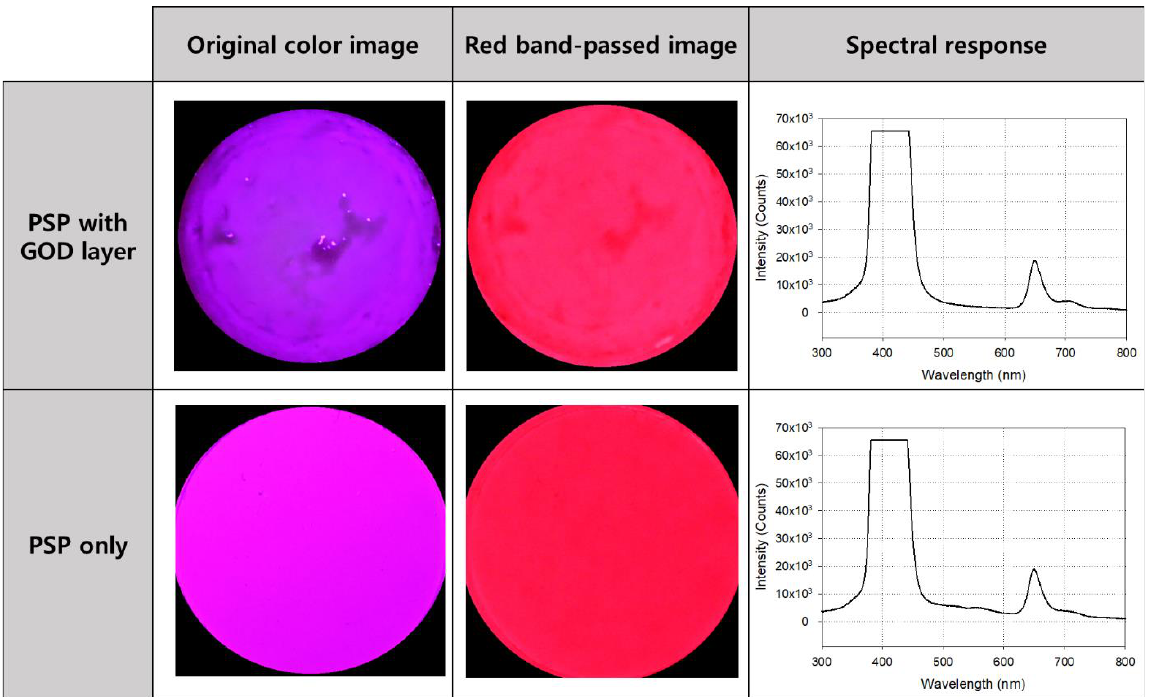
Figure 4. Photos and the excitation and emission spectrums of the sensor before (lower row) and after (upper row) the glucose oxidase (GOD) layer application. The spectral curves on the right side were obtained without using a bandpass filter.